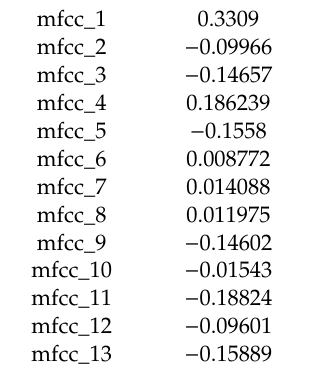
Table 4. The results of correlation analysis for Mel frequency cepstral coe ffi cients (MFCC) and the